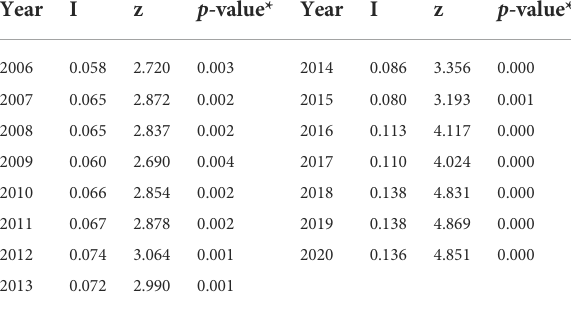
TABLE 2 Moran ’ s I index of GTFEE.